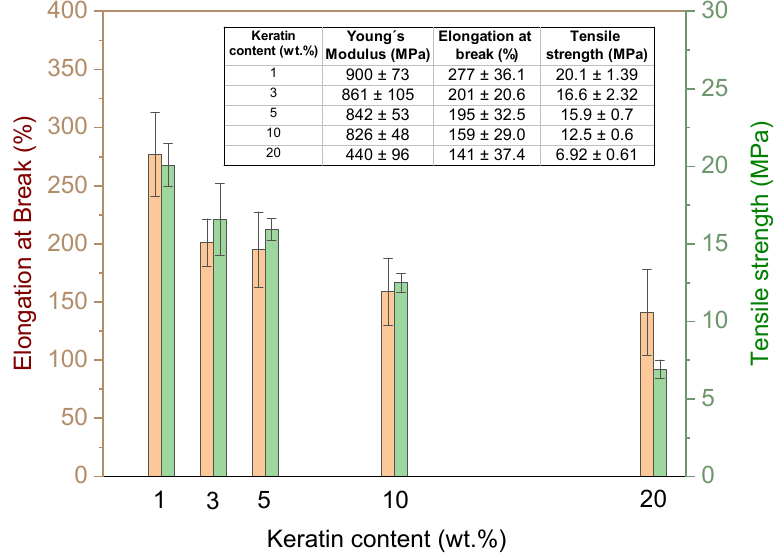
Figure 3. Changes in tensile properties ( E, ε B, σ M ) for (PLA)/PHB/ATBC blend before and after addition of di ff erent amount of keratin varying from 1 to 20 wt % of different amount of keratin varying from 1 to 20 wt % loading.